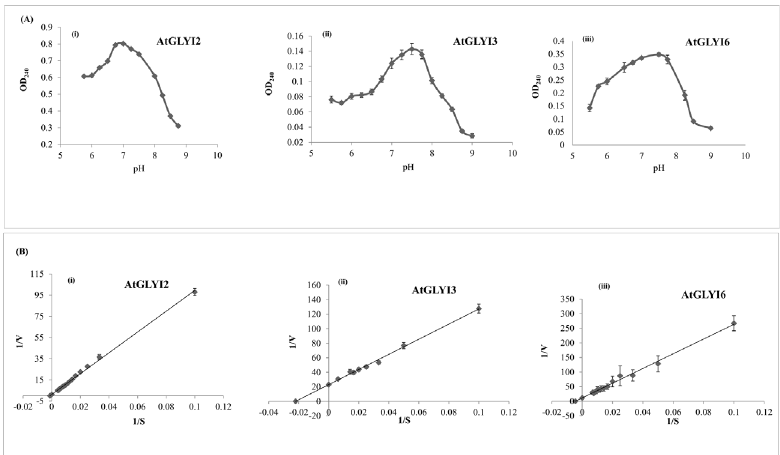
Fig 3. Kinetic parameters of purified AtGLYI proteins. (A) Upper panel shows graphs depicting effect of change in pH on the activity of (i) AtGLYI2, (ii) AtGLYI3 and (iii) AtGLYI6 proteins. A range of pH conditions analyzed and the corresponding absorbance indicative of protein activity is shown on X-axis and Y-axis, respectively. All the three proteins were purified using Ni-NTA affinity chromatography. The activity of purified proteins was checked over a wide range of pH in different buffers (pH 5.5 – 6.75: MES buffer, pH 6.5 – 8.0: MOPS buffer, pH 7.40 – 9.0: tris buffer). The optimal pH for AtGLYI2 is 7.0; AtGLYI3 is 7.5 and AtGLYI6 is 7.5. (B) Lower panel shows graphs depicting kinetic parameters for (i) AtGLYI2, (ii) AtGLYI3 and (iii) AtGLYI6. These parameters were calculated using Lineweaver Burk ’ s plot. GLYI assay was performed with purified proteins with varying concentration of GSH and increase in absorbance (240 nm) with time was monitored. From the data obtained, Lineweaver Burk ’ s plot was made and various kinetic parameters were calculated.